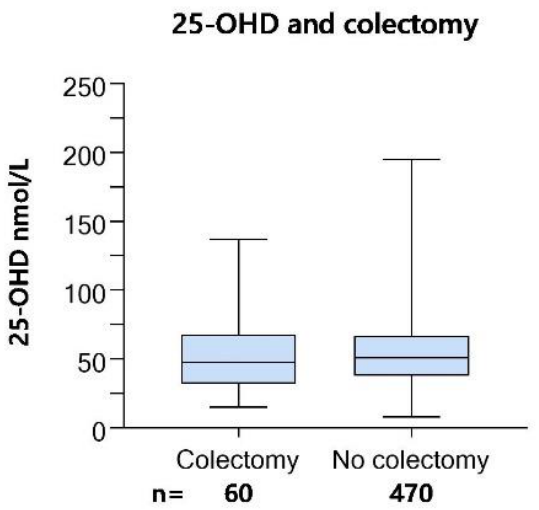
Figure 7. Cross-sectional 25-OHD in colectomized patients. Median 25-hydroxyvitamin D (25-OHS) values in nmol/L in colectomized and non-colectomized patients from the screening cohort of the ‘Palliative-D’-study. Boxes show interquartile range and whiskers min-max values. There was no statistically significant difference between groups (Fischer’s exact test).